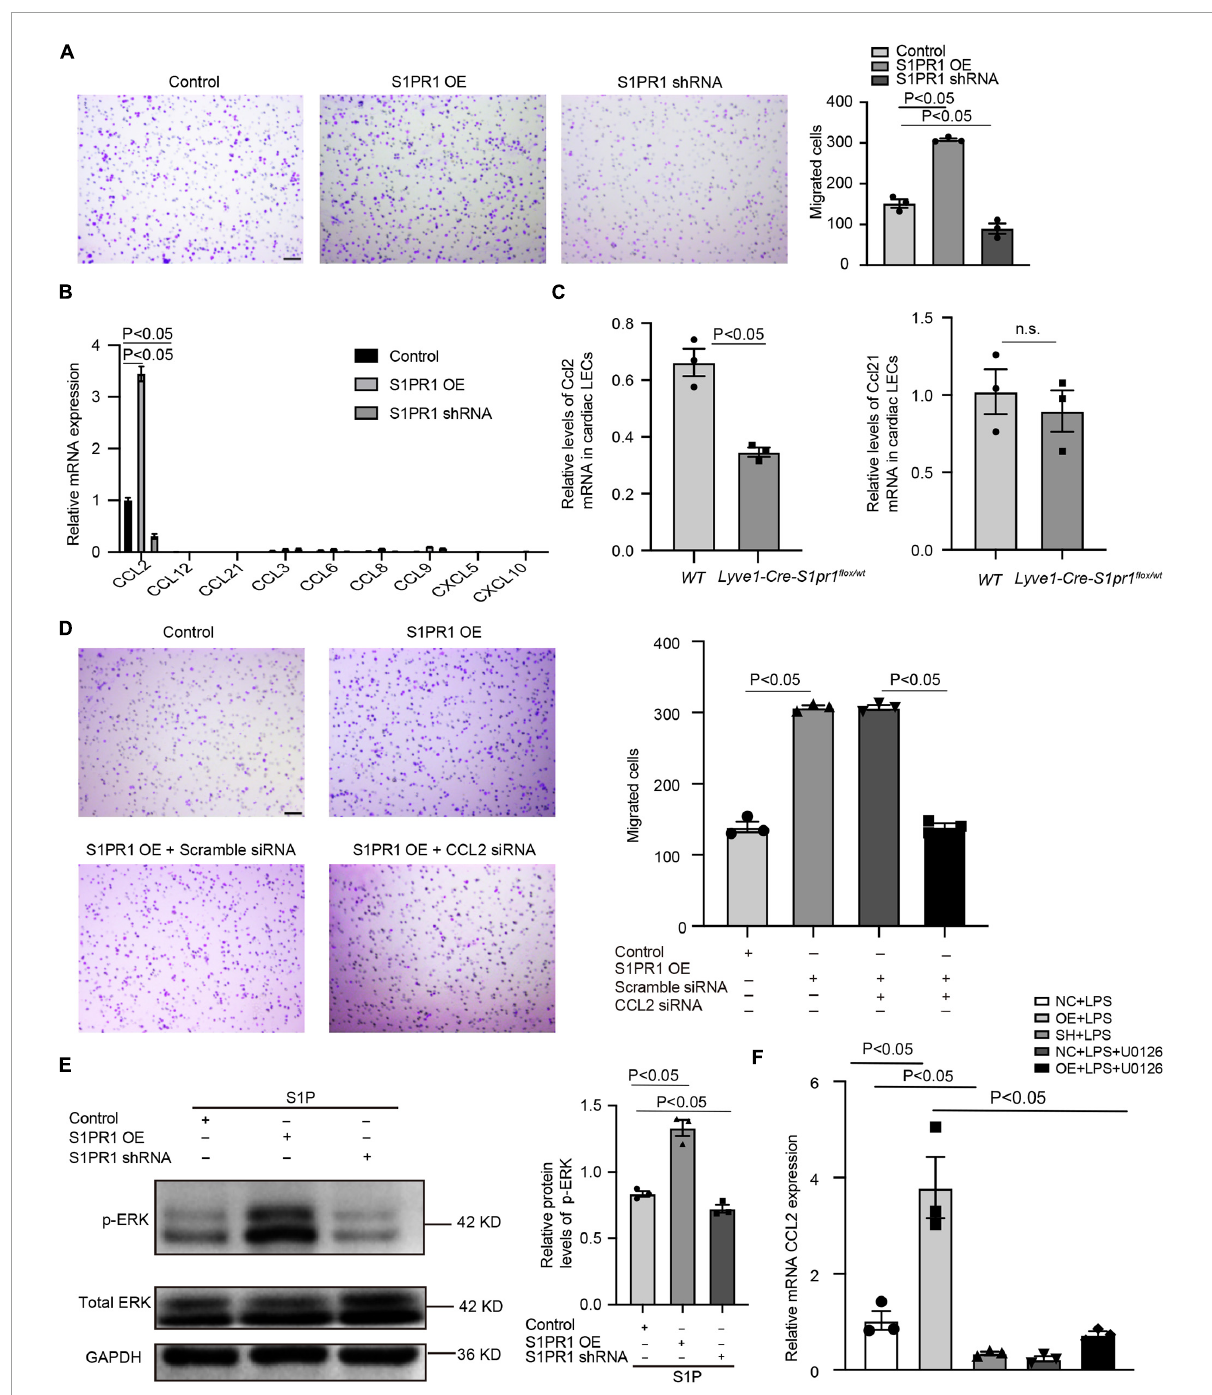
FIGURE6 LEC-S1pr1 regulates macrophage trafficking via ERK/CCL2 signaling pathway. (A) The representative images of transwell cell migration assay of THP-1 cell lines, which were co-cultured with condition medium obtained from LECs of the indicated groups, with their quantification of migrated cells ( n = 3). (B) RT-qPCR analysis showed the relative mRNA expression levels of different chemokines in the indicated groups ( n = 3). (C) RT-qPCR analysis showed the relative Ccl2 and Ccl21 mRNA expression levels in LECs from hearts of the indicated groups at 7 days after MI ( n = 3). (D) The representative images of Boyden chamber assay of THP-1 cell lines, which were co-cultured with the conditioned medium obtained from LECs of the indicated groups, with their quantification of migrated THP-1 ( n = 3). (E) Western blotting analysis of ERK activation status in LECs treated with S1P in the indicated groups with their quantification of the ratio of p-ERK/total ERK ( n = 3). (F) RT-qPCR showed the CCL2 mRNA expression of the indicated groups ( n = 3). U0126, ERK inhibitor. Scale bars for (A,C) 100 µ m. Data are mean ± S.E.M. n.s., no statistical